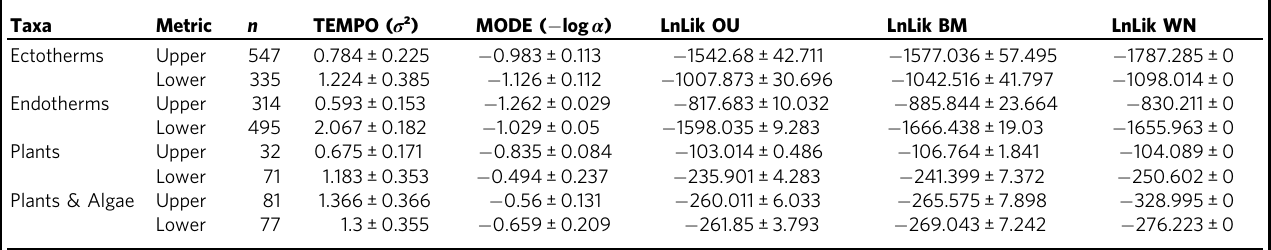
Table 1 Tempo and mode of evolution of upper and lower thermal tolerances of ectothermic species, endothermic species, terrestrial plants and plants and algae.